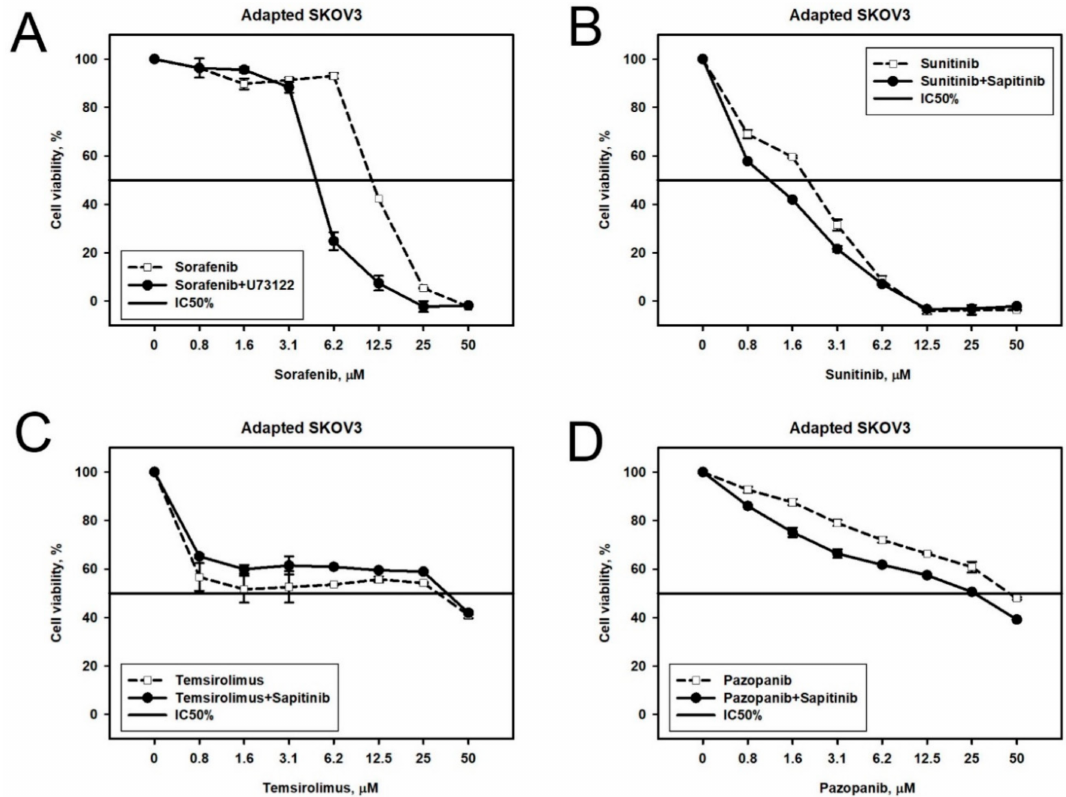
Figure 6. Viability of target drug resistant SKOV-3 cells treated with different combinations of target drugs: ( A ) Sorafenib-resistant cells treated with (i) combination of Phospholipase C inhibitor U73122 and Sorafenib or (ii) Sorafenib alone; ( B ) Sunitinib-resistant cells treated with (i) combination of EGFR inhibitor Sapitinib and Sunitinib or (ii) Sunitinib alone; ( C ) Temsirolimus-resistant cells treated with (i) combination of Temsirolimus and EGFR inhibitor Sapitinib or (ii) Temsirolimus alone; ( D ) Pazopanib-resistant cells treated with (i) combination of Pazopanib and EGFR inhibitor Sapitinib or (ii) Pazopanib alone. Dashed line corresponds to single drug, solid